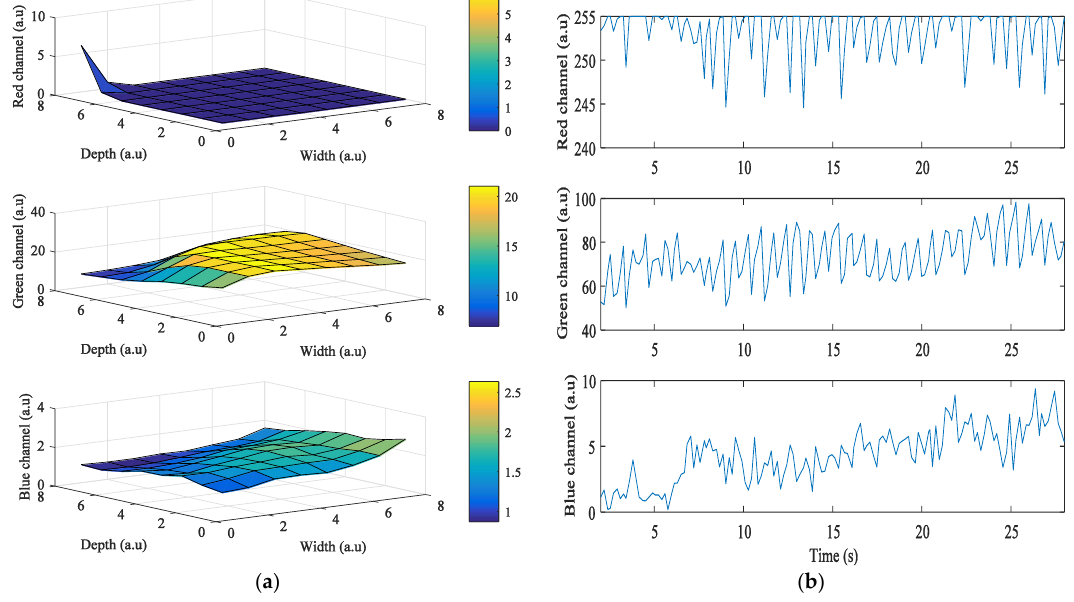
Figure 13. Example of quality analysis of PPG signals obtained from a subject using HTC One M8 with the flash off: ( a ) intensity change distribution; ( b ) intensity of PPG signal.